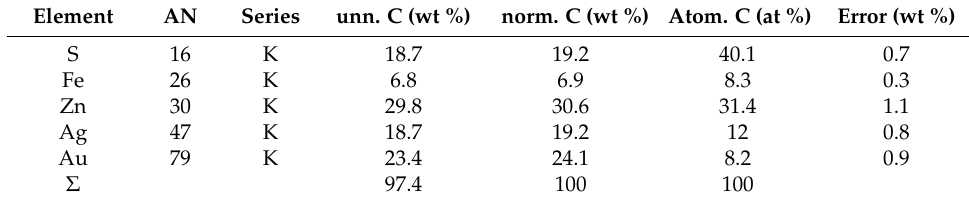
Table 6. Chemical composition of Bi inclusion in wt %/at % (EPMA-EDX) (AN = atomic number, series = emitted X-ray series, unn. C = non corrected carbon, norm. C = normalized carbon, Atom. C = corrected atomic carbon).